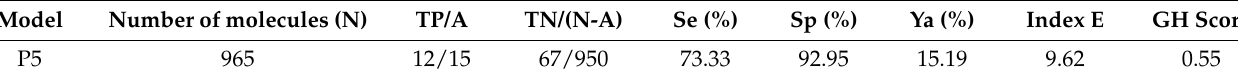
Figure 2. A hydrophobic factor was added to four-point pharmacophore model. Table 4. Evaluation results of P5 pharmacophore model by decoy set.